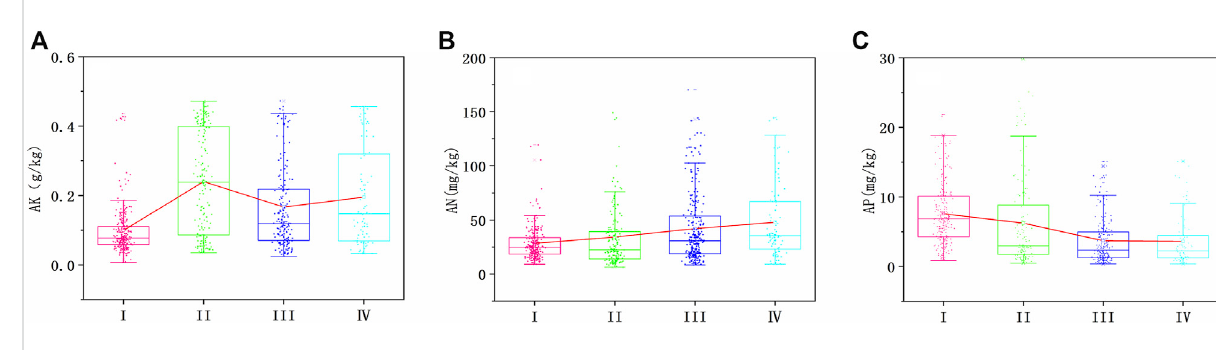
FIGURE 8 Response threshold distribution of nutrients (AK, AN and AP) in salt meadow soil on lake